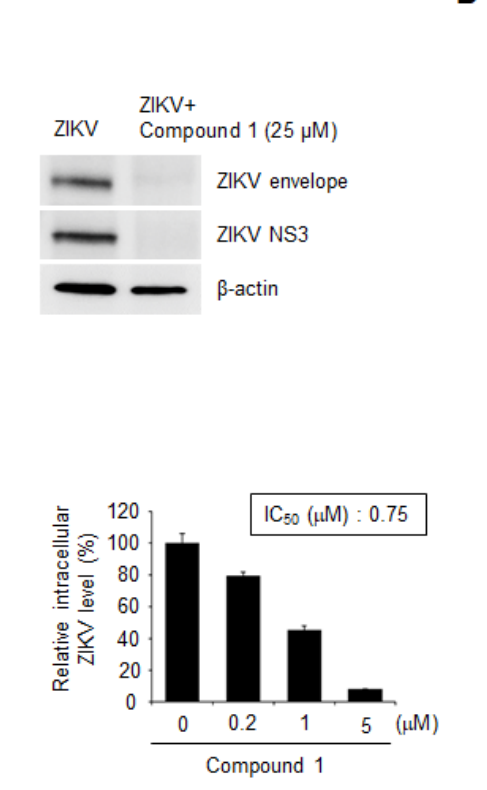
Figure 2. Compound 1 potently inhibits ZIKV infection of HEK-293 cells. ( A ) HEK-293 cells were simultaneously incubated with ZIKV (strain: PRVABC59) and compound 1 (25 µ M). After 72 h, cell extracts were prepared from the cells and subjected to Western blot analysis with anti-ZIKV envelope and anti-ZIKV NS3 antibodies. β -actin was used as a loading control. ( B ) Cellular RNAs were prepared from cells in ( A ) and subjected to real-time RT-PCR for ZIKV RNA. ( C ) Cellular RNAs were isolated from cells infected with ZIKV and treated with the indicated concentrations of compound 1. The level of ZIKV RNA was measured by real-time RT-PCR. Antiviral activity (IC 50 ) was determined from a dose-response curve.